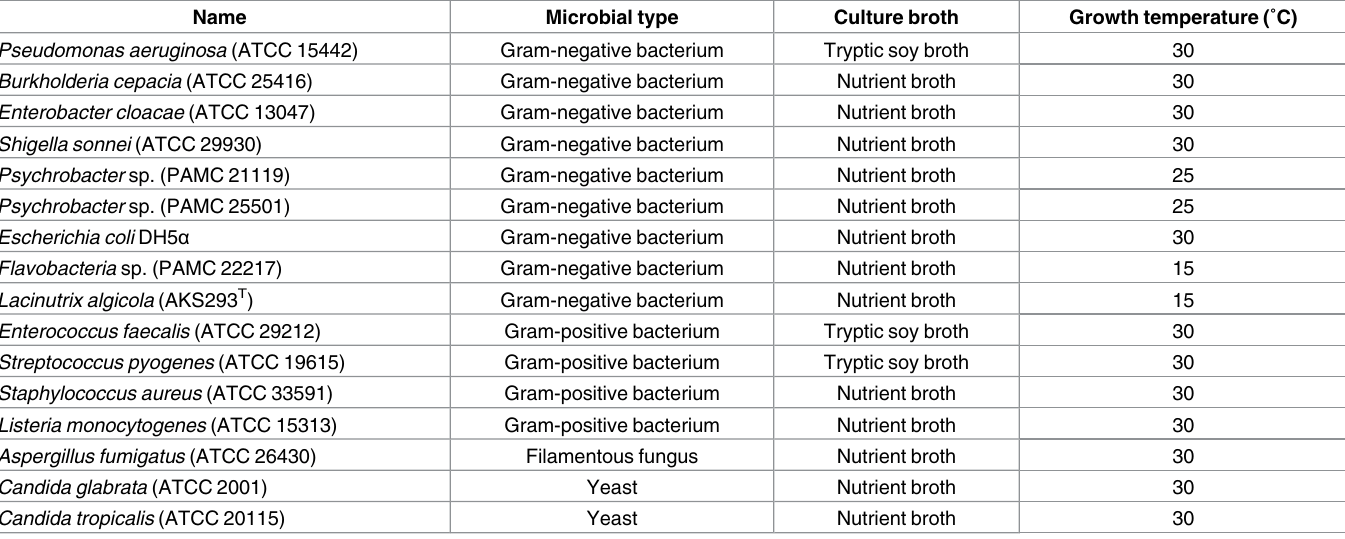
Table 2. Microbial strains and culture